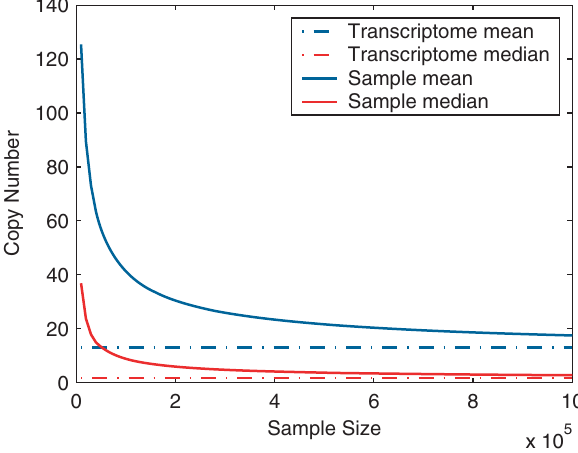
Figure 4. Mean and median copy numbers of detected transcripts at different sampling stages. Monte Carlo simulation is done with the fitted RAD and estimated transcriptome diversity S of the pooled library. Assuming there are 1,000,000 copies of transcript per cell, the mean and median copy numbers of all detected transcripts at each sampling stage are